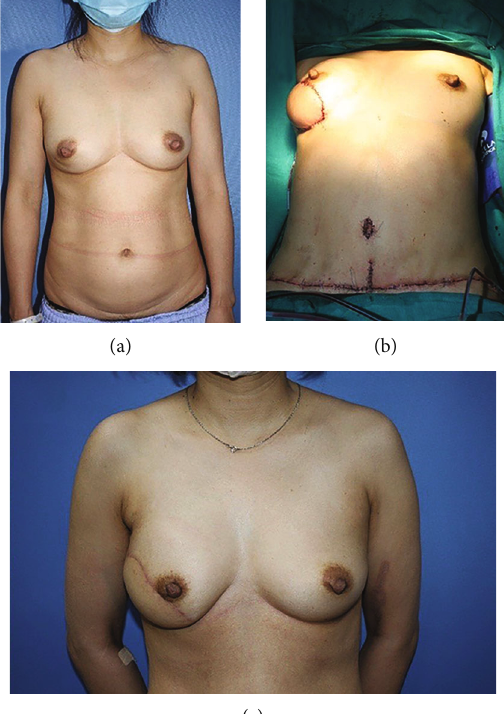
Figure 3: The preoperative (a), operation day (b), and 6-week postoperative (c) view of a 45-year old woman after immediate DIEP fl ap breast